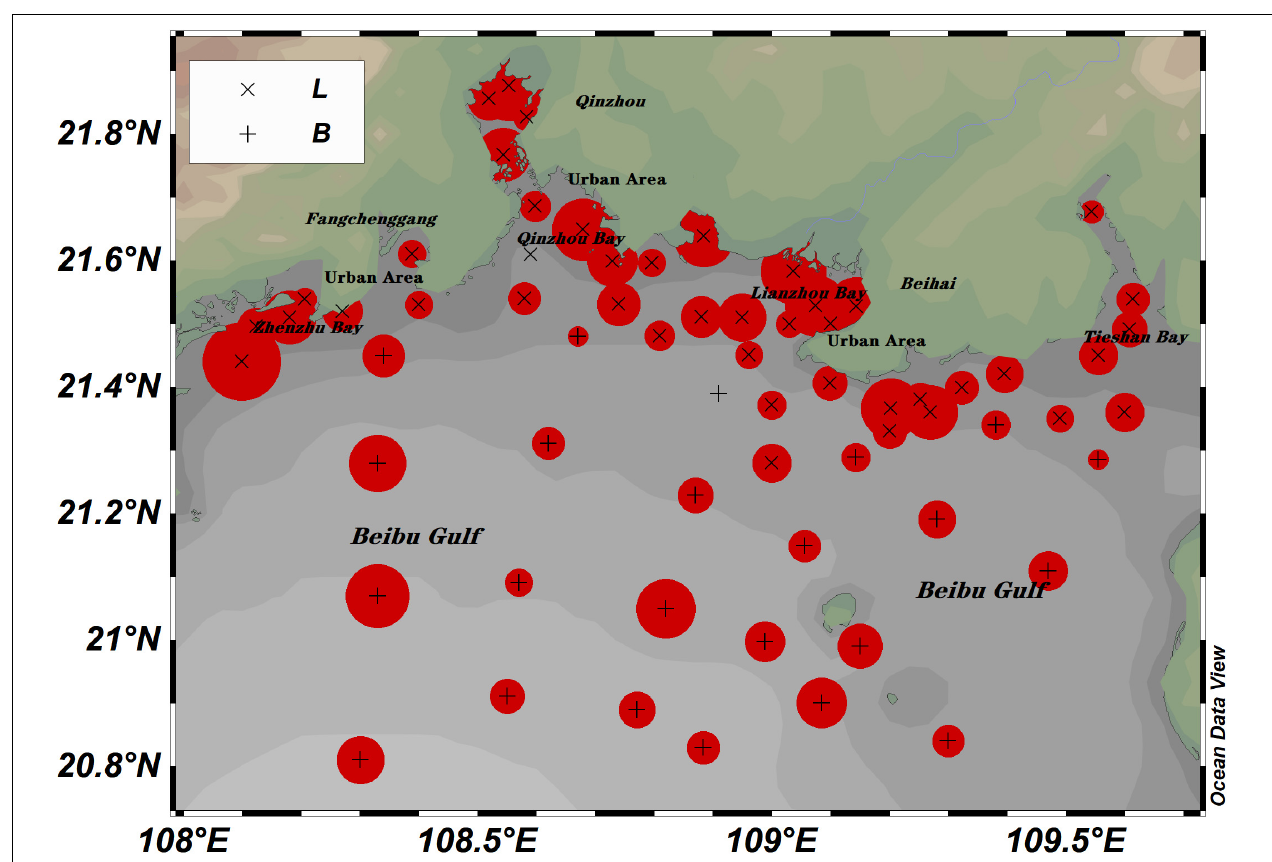
FIGURE 6 | Distributions of microplastics in sediment from L and B stations.